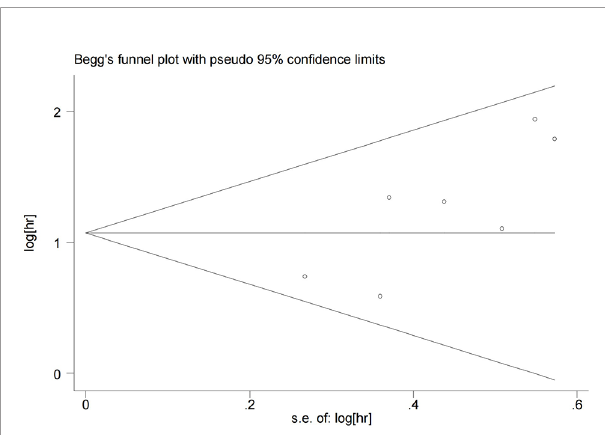
FIGURE 4 | Funnel plots for detecting publication bias of the association between Ki-67 expression level and overall survival of